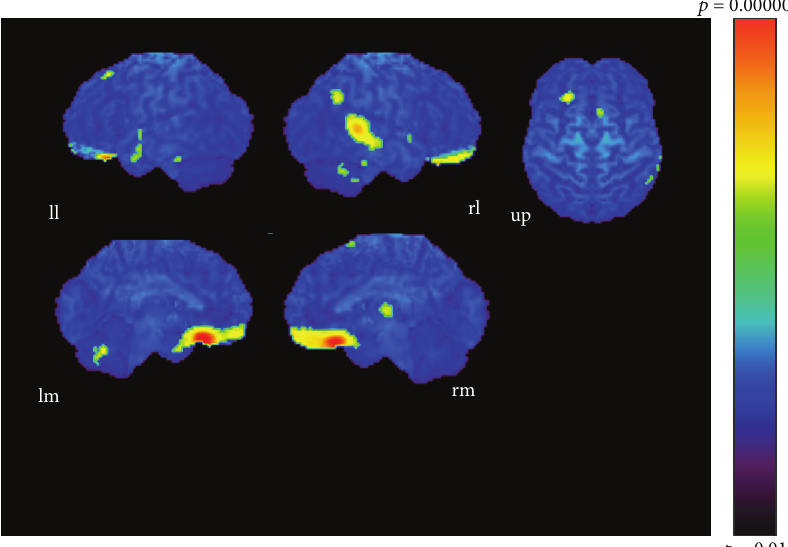
Figure 7: Chord-complex condition ( 𝑝 < 0.001 ). ll: lateral surface of left hemisphere; lm: medial surface of left hemisphere; rl: lateral surface of right hemisphere; rm: medial surface of right hemisphere; up: upper surface.